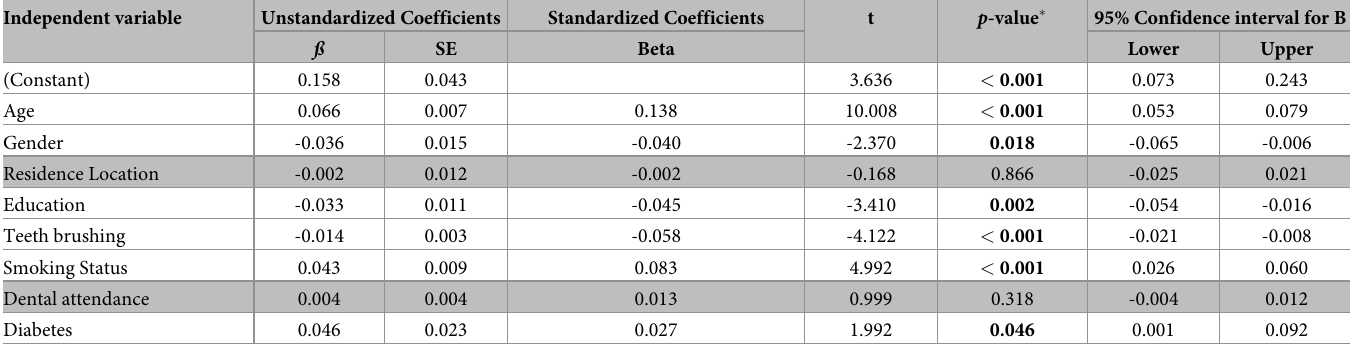
Table 4. Multivariate logistic regression for